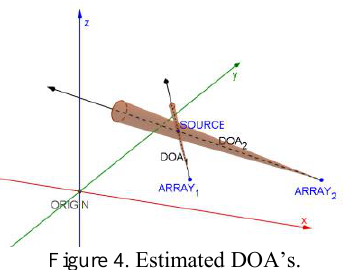
Figure 4. Estimated DOA’s.